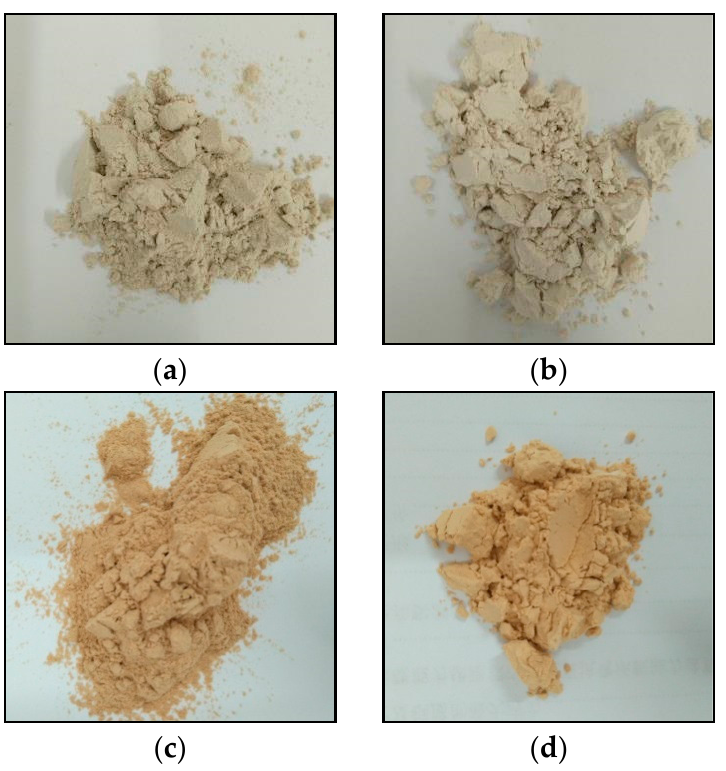
Figure 2. Appearance changes in raw ore and high ‐ viscosity ore after calcination at 650 °C. ( a ) Raw ore; ( b ) High viscosity ore; ( c ) Calcined raw ore under 650 °C; ( d ) Calcined high viscosity ore under 650 °C.